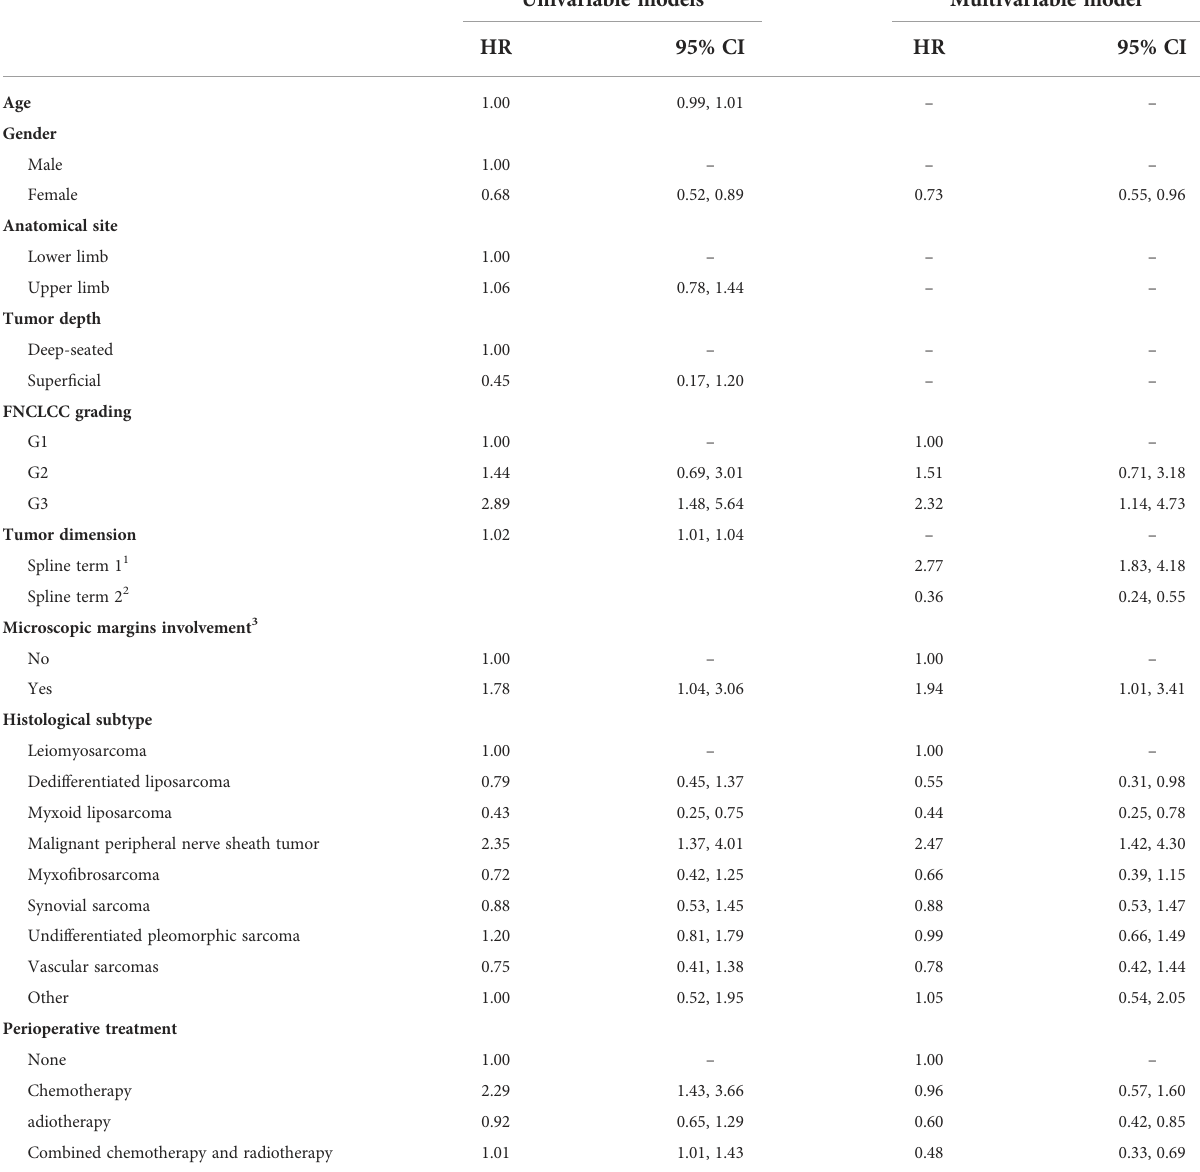
TABLE 4 Hazard ratios and 95% con fi dence intervals from the univariable and multivariable Cox proportional hazards models predicting 10-year distant